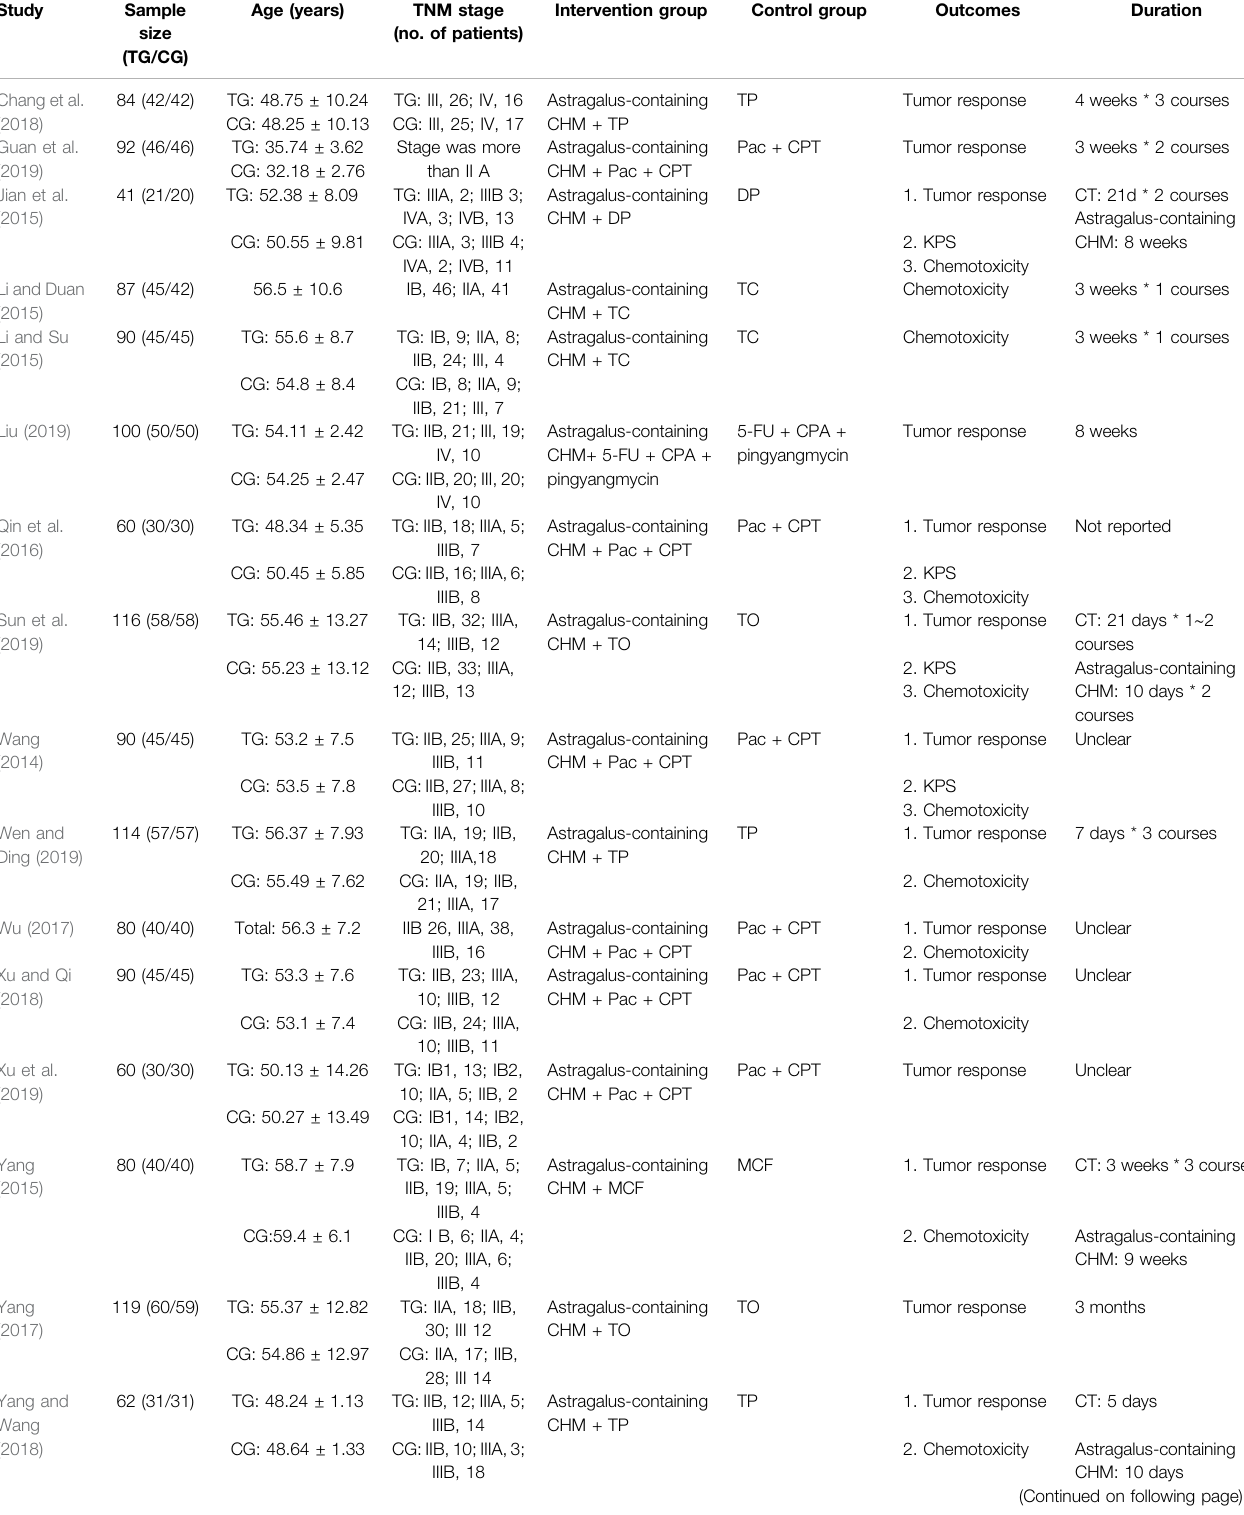
TABLE 1 | Characteristics of included